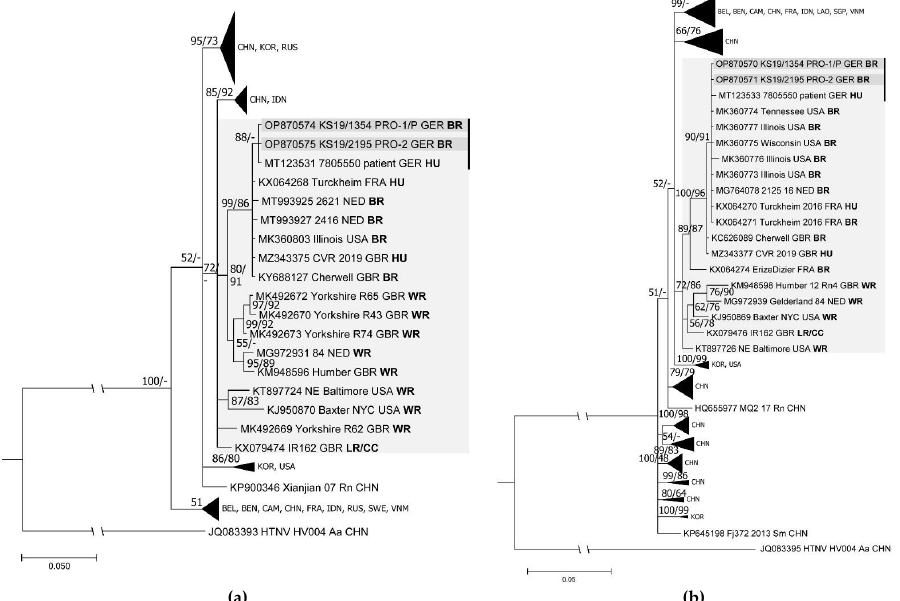
Figure 2. Phylogenetic trees of partial Seoul virus (SEOV) sequences from patient and rats. ( a ) The partial L segment consensus tree was based on the HKY substitution model with gamma distribu- tion for Bayesian analyses of 8 × 10 6 generations and the TPM1uf substitution model with gamma distribution and invariant sites for maximum likelihood analyses with an alignment length of 291 nucleotides and 1000 bootstrap replicates. ( b ) The partial S segment consensus tree was recon- structed using the TPM2 substitution model with gamma distribution for both the Bayesian (1 × 10 7 generations) and maximum likelihood analyses (1000 bootstrap replicates) using sequences of 515 nucleotides in length. The consensus trees were based on the Bayesian method. Bootstrap values from the maximum likelihood analyses were only transferred to the consensus tree if the branches were consistent. Posterior probabilities are given before and bootstrap values behind or below slashes. Relevant clades are highlighted by a light grey background. Sequences derived from the same outbreak are marked by a black bar, while novel sequences from the pet rats are indicated in darker grey. Country abbreviations: BEL, Belgium; BEN, Benin; CAM, Cambodia; CHN, China; FRA, France; GBR, Great Britain; GER, Germany; IDN, Indonesia; KOR, Korea; LAO, Laos; NED, the Netherlands; RUS, Russia; SGP, Singapore; SWE, Sweden; USA, United States of America; VNM, Vietnam. Other abbreviations: HU, human; PRO-1/P, pet-rat owner 1/patient; PRO-2, pet-rat owner 2; Rn, Rattus norvegicus ; BR, breeder rat; CC, cell culture isolate; LR, laboratory rat; WR, wild rat. The categorization of the rats was according to [10,19,20,43 – 47].